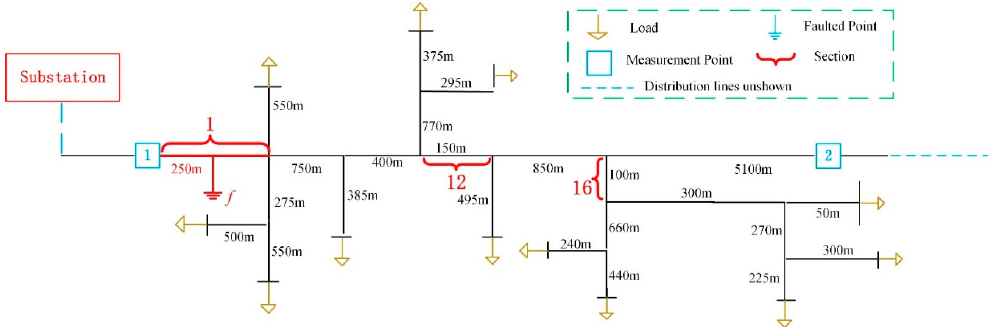
Figure 7. Relationship between the fault distance and lengths of direct sections.